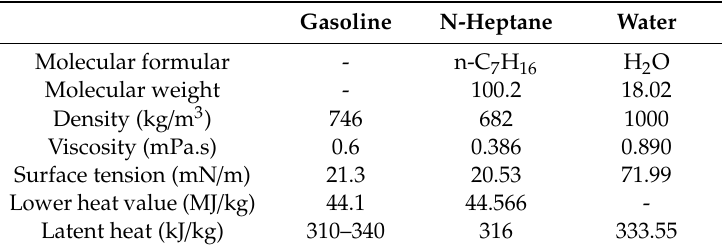
Table 1. Properties of test fuels.